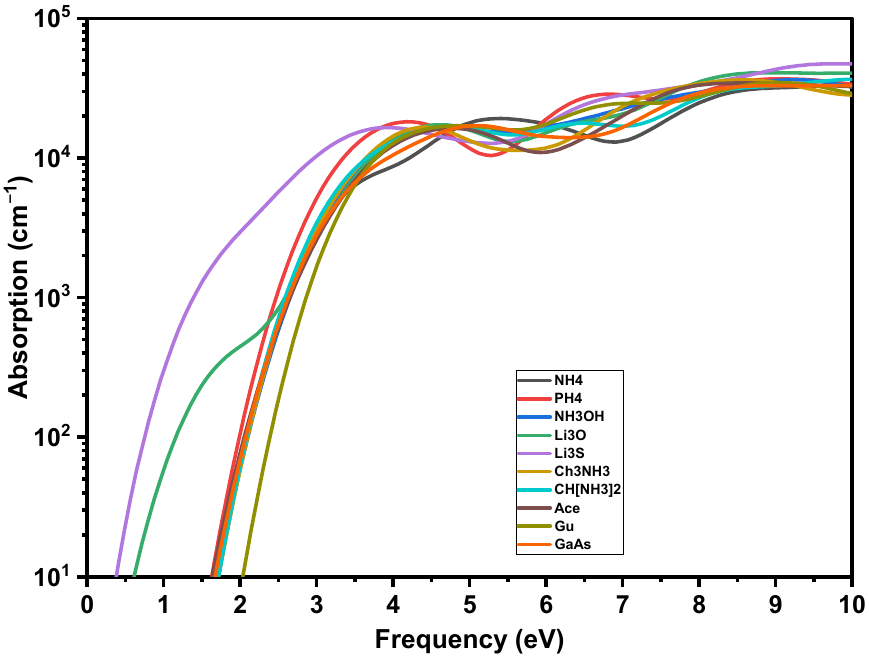
Figure 8. Absorption coefficients of crystalline GaAs and A i PbI 3 perovskite.